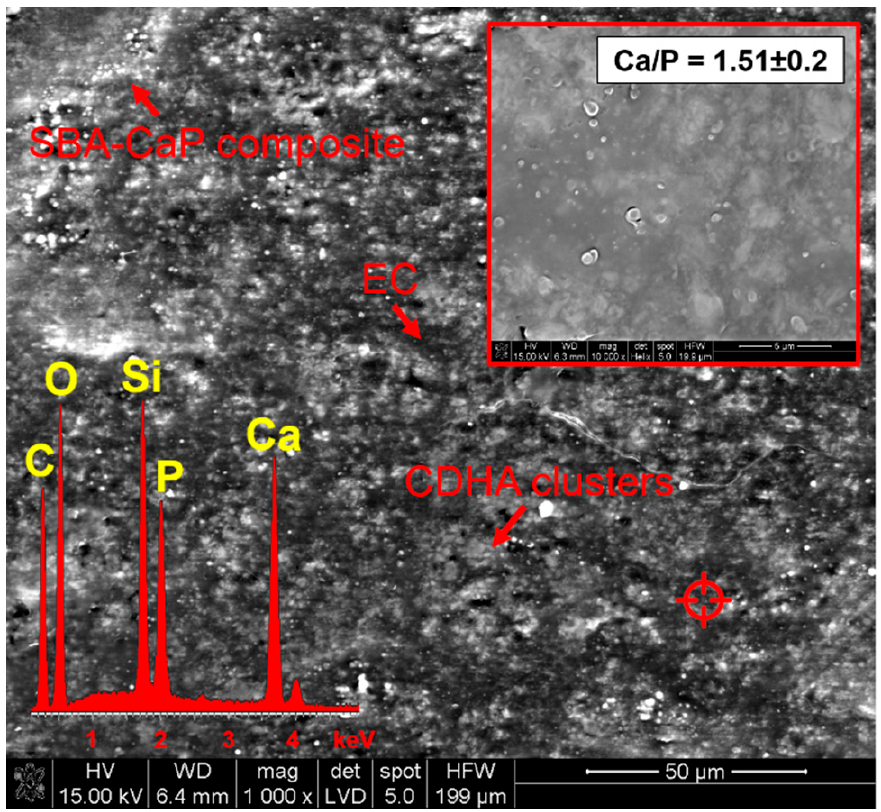
Figure A1. SEM-EDX micrograph of primarily obtained membrane after 21 days of immersion in simulated body fluid.